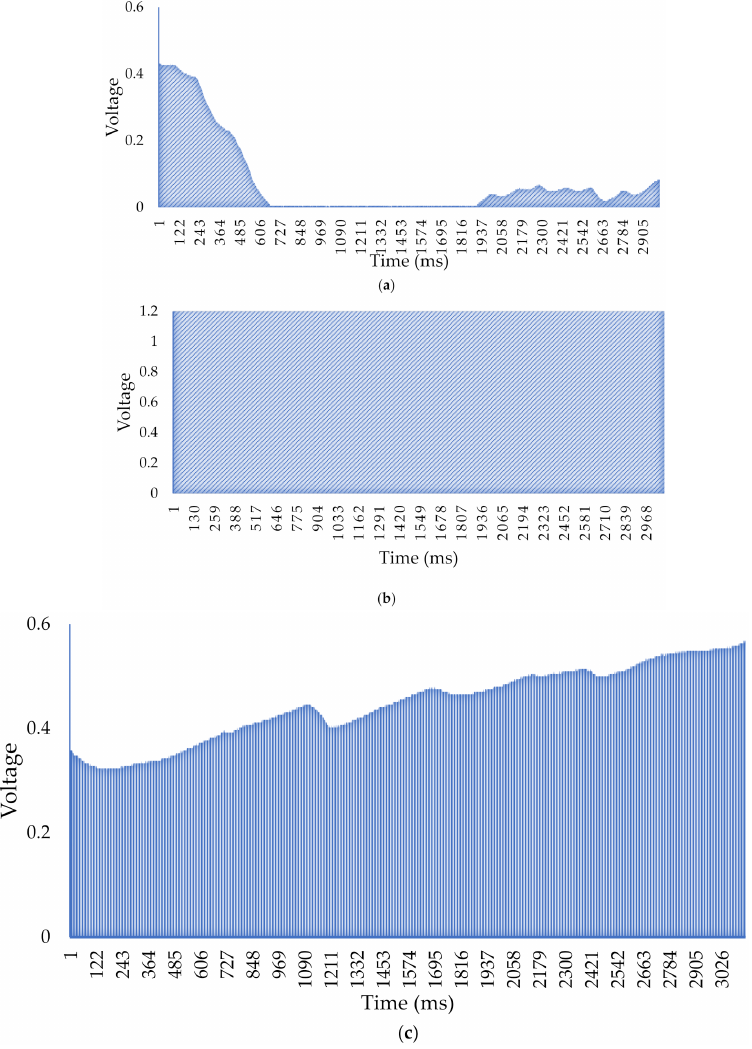
Figure 4. ( a ) Video analysis of User ‘1’. ( b ) Timer clock analysis of User ‘1’; ( c ) Reading analysis of User